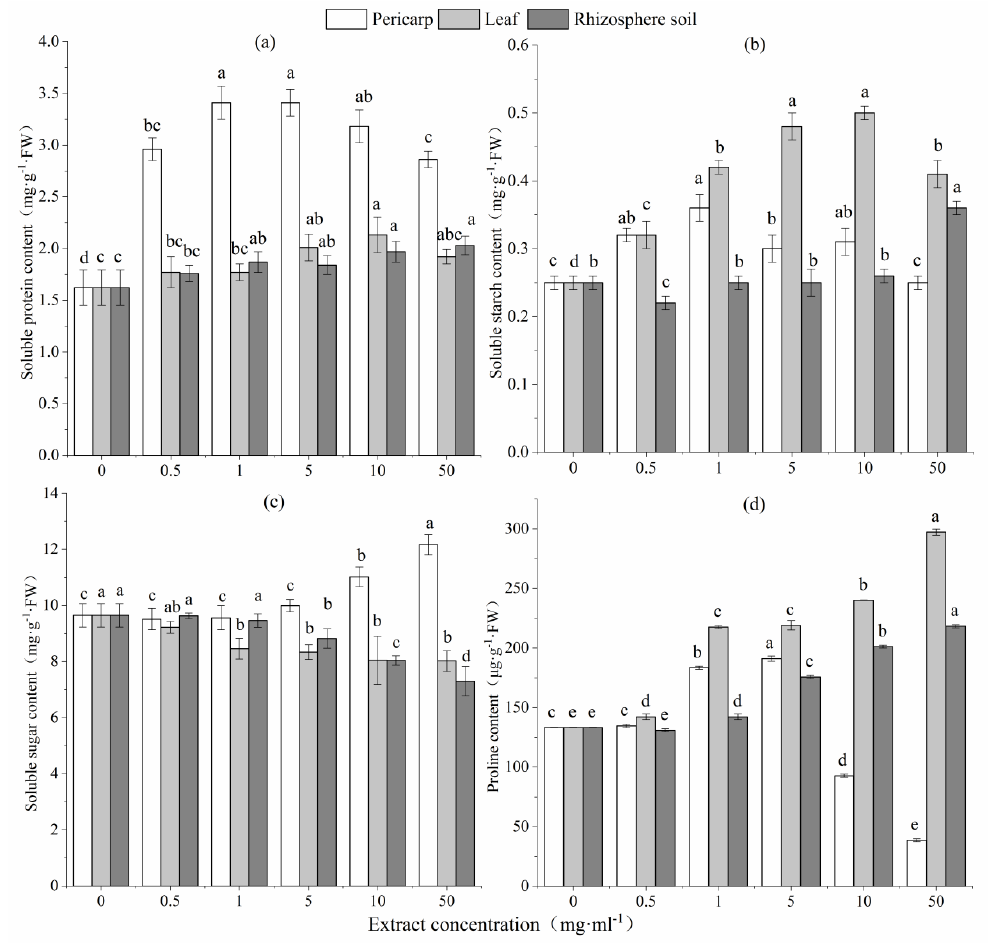
Figure 3. Soluble protein ( a ), soluble starch ( b ), soluble sugar ( c ), and proline ( d ) contents of L. formosana seedlings following treatment with different concentrations of C. migao pericarp, leaf, and rhizosphere soil aqueous extracts. Lowercase letters represent significant differences in each treatment group ( p < 0.05).